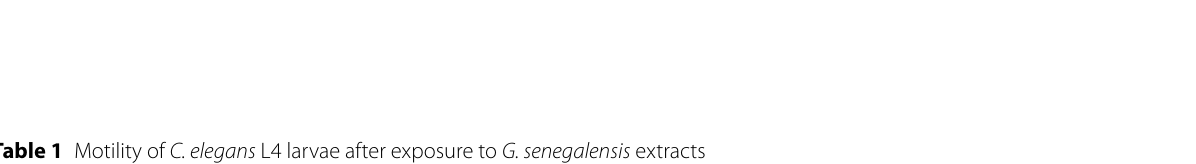
Table 1 Motility of C. elegans L4 larvae after exposure to G. senegalensis extracts